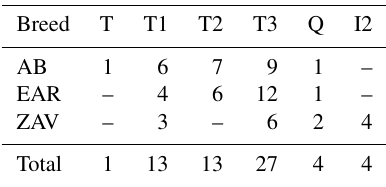
Table 2. Haplogroup distribution of individuals of native Turkish cattle